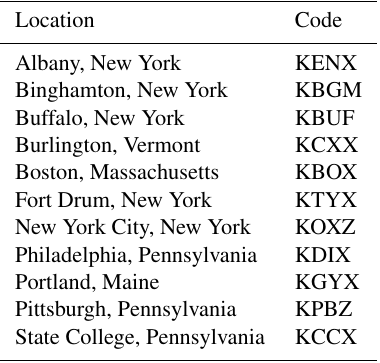
Table B1. NEXRAD radars used to produce the dataset used in this study.